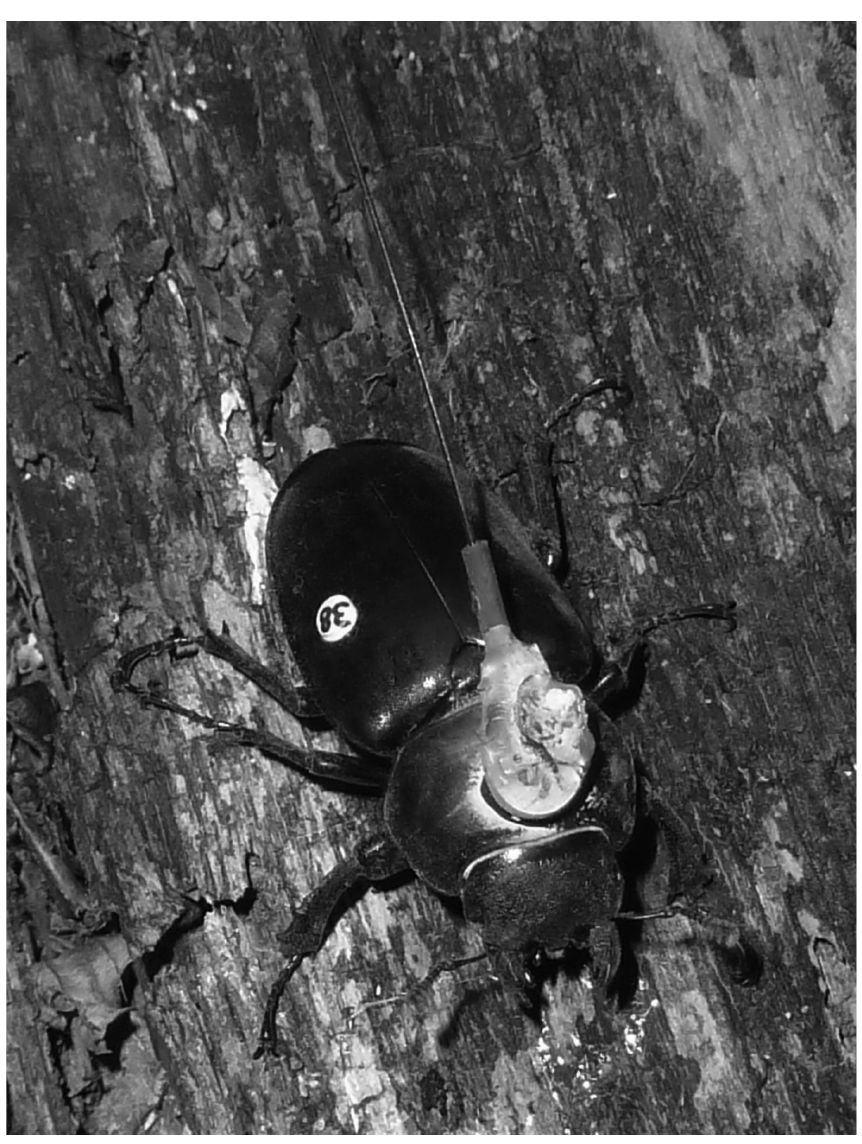
Figure 1. A female of Lucanus cervus marked with a numbered sticker on the right elytron and equipped with a battery-powered radio transmitter (LB-2X / 0.31g; Holohil Systems Ltd., Carp, Ontario, Canada).